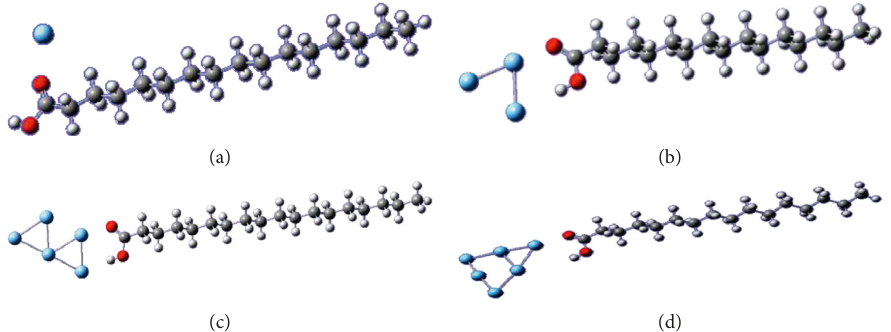
Figure 4: Optimized geometries of palmitic acid with (a) a single silver atom, (b) cluster of 3 silver atoms, (c) cluster of 5 silver atoms, and (d) cluster of 6 silver